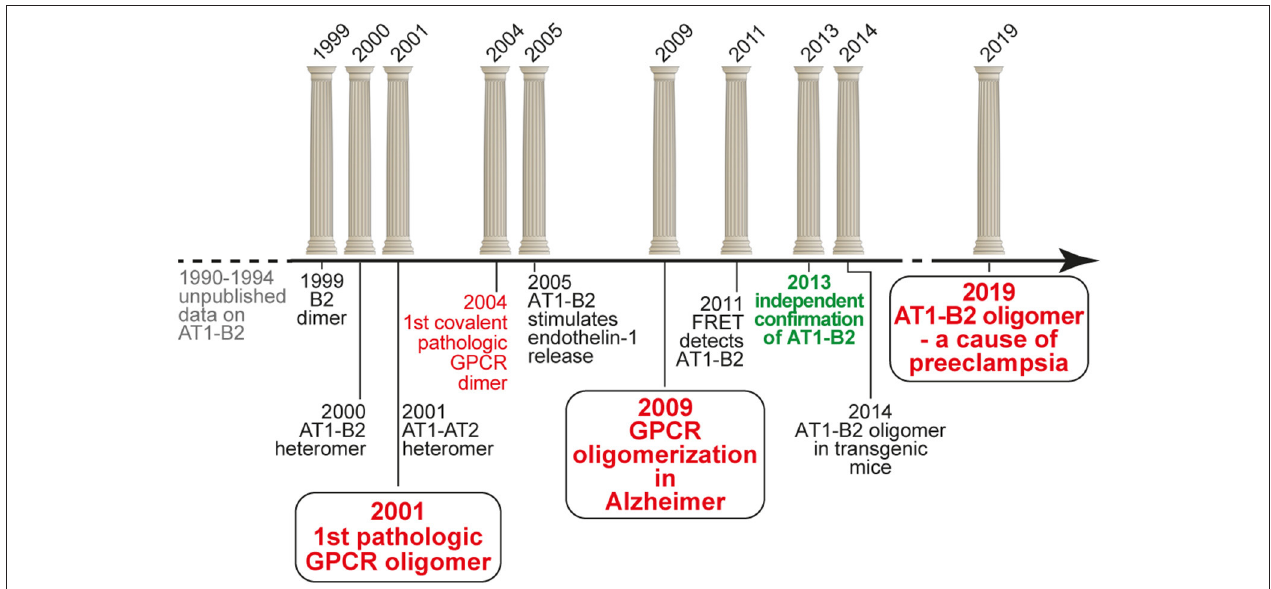
FIGURE 1 | Timeline of the discovery of pathologic GPCR